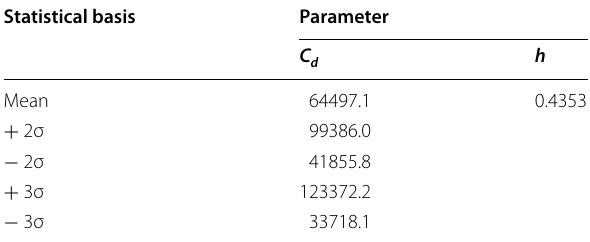
Table 5 Master S–N fitting curve parameters of the base metal Statistical basis